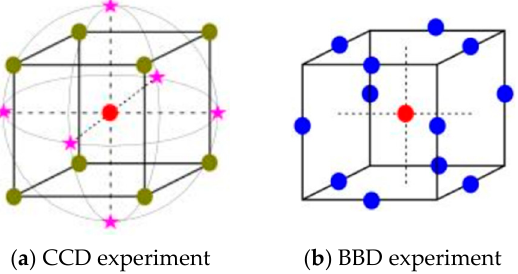
Figure 1. The experimental runs of the central composite design (CCD) and Box–Behnken design (BBD).